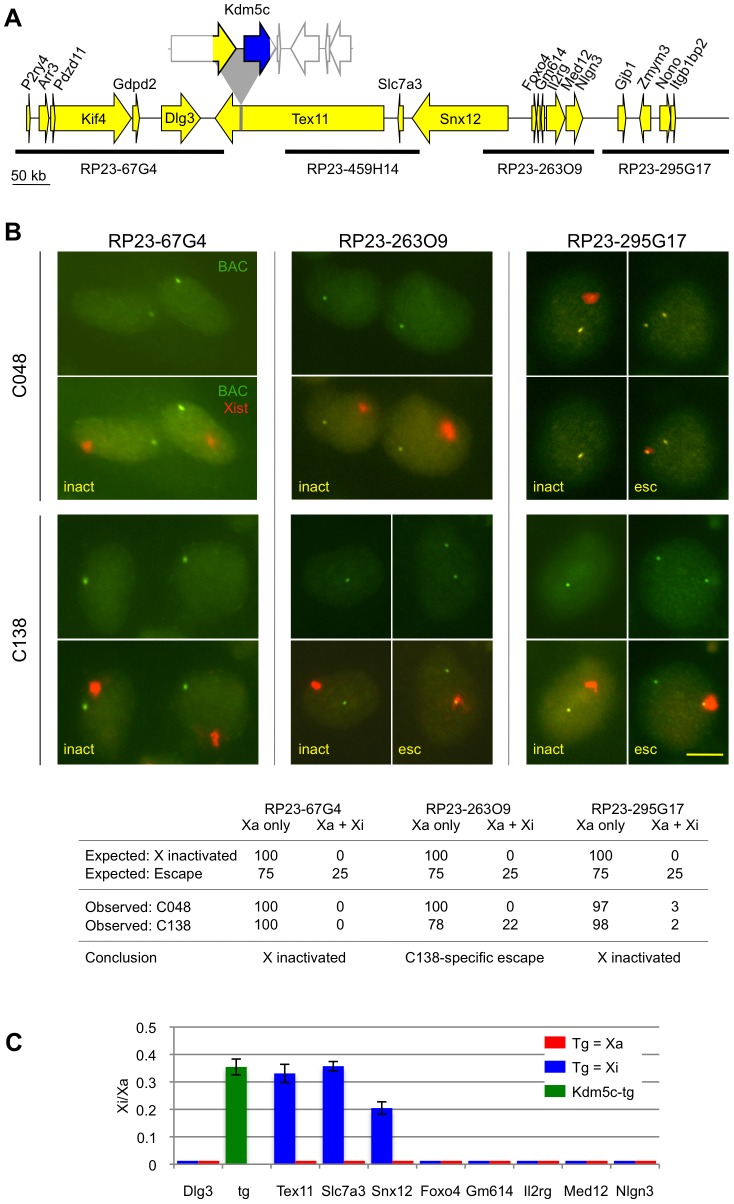
Disruption of distal XCI regulation.(A) Tex11 locus with the C138 transgene drawn to scale. (B) RNA FISH for BAC probes flanking the C138 transgene insertion are compared to C048 (non-transgenic at the Tex11 locus). Scale bar = 10 µm. Expected values used to conclude aberrant escape (p<0.001) consider the proportion of cells that inactivate the transgenic X due to XCI skewing. 100 cells were scored and the percentage with each expression pattern is indicated. (C) XCI status of clonal C138 cell lines that carry the transgene on the active or inactive X. Inactive X expression is indicated as a proportion of active X expression. Kdm5c-tg escape was estimated as described (see methods). No inactive X expression was detected for most genes tested, indicating that levels are at or below assay sensitivity of ∼1% of active X expression. All reactions were performed at least twice, with error bars indicating the standard deviation of technical triplicates.